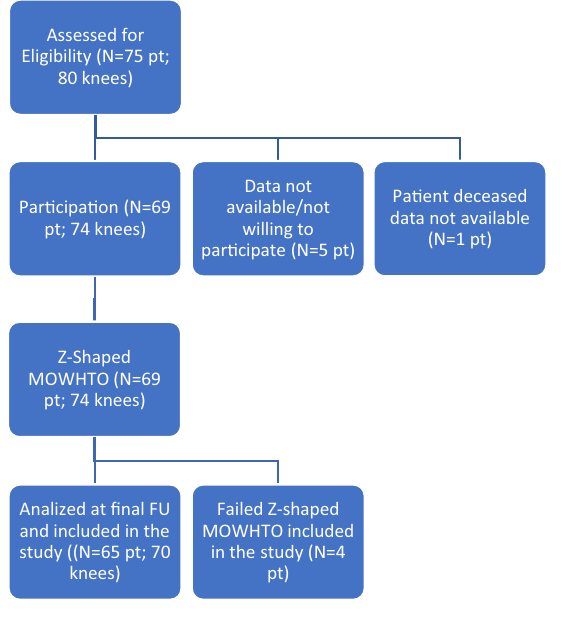
Table 1 Enrollment process flow diagram